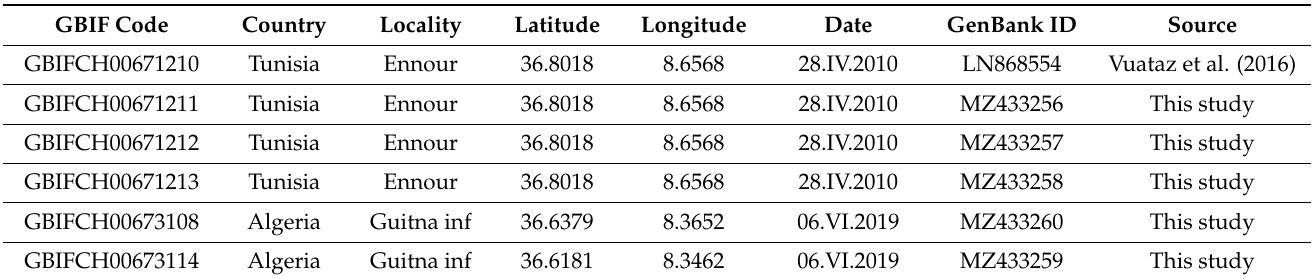
Table 1. Codes and origin of specimens examined in the COI analysis. For each specimen, the GBIF code, the sampling information (country, locality, coordinates, and date of sampling), the GenBank accession number of the COI sequence, and the corresponding publication source are provided. All specimens from Tunisia are from the type locality (topotypes). GBIF